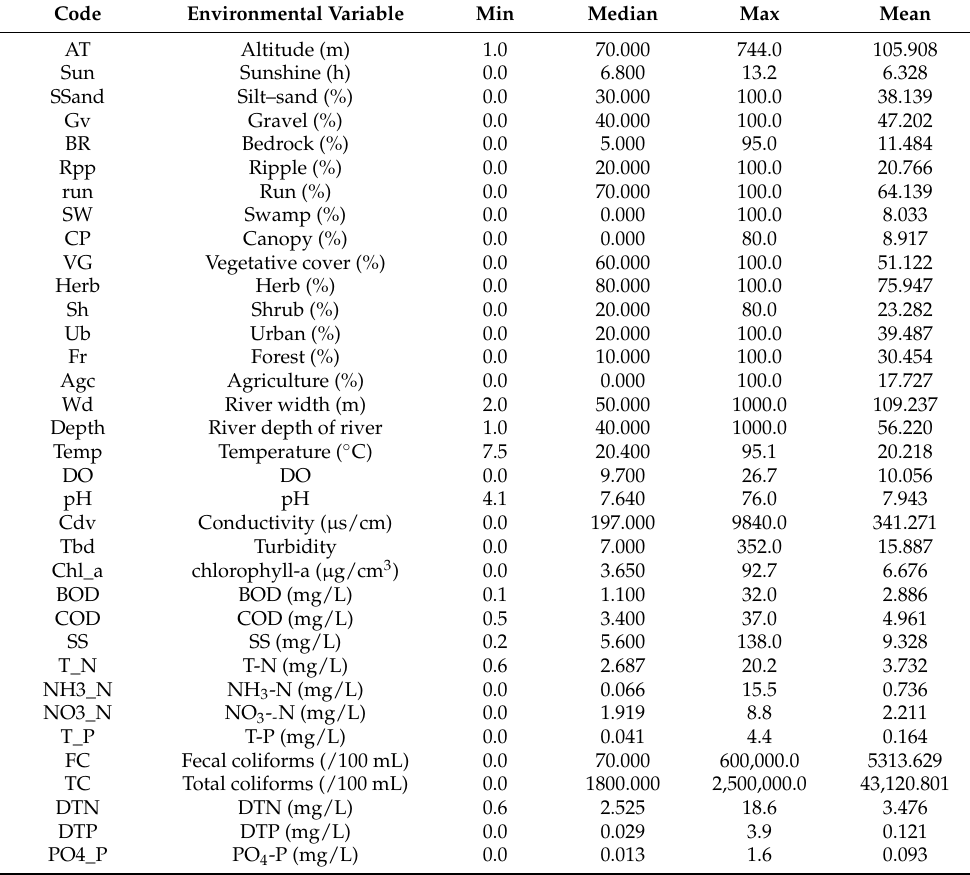
Table 3. Four descriptive statistics for 35 environmental